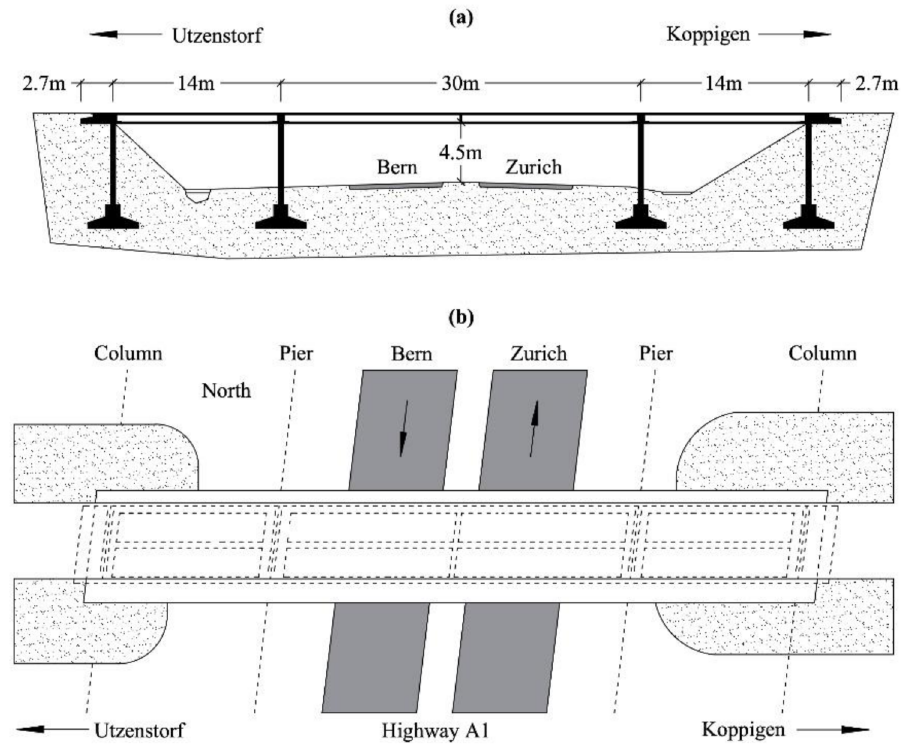
Figure 9. Z24 Bridge: ( a ) longitudinal section and ( b ) top view, adapted from [42]. Starting from the raw data, a modal analysis based on the frequency domain decom- position (FDD) technique was carried out to extract the frequencies of the four fundamental vibration modes and assess their variations due to the environmental conditions. The resulting set of data consists of 3932 measurements, out of which the first 3470 refer to the undamaged, normal condition, and the last 462 ones are associated with the damaged state. Figure 10 collects the exemplary time histories of the modal frequencies relevant to the first and fourth modes: in the plots, the oscillations in the values related to the normal condition were induced by temperature fluctuations in cold periods; these results have clearly testified the high sensitivity of the natural frequencies to the environmental variability. A data normalization procedure based on an auto-associative artificial neural network (AANN) [43] was then adopted to remove such environmental variability from the variation in time of the vibration frequencies and obtain feature samples linked to the damage state only. In compliance with standard approaches in machine learning, 90% of the frequency data regarding the normal condition were handled as the training set, thus including 3123 samples of the four variables (that are the modal frequencies). The last remaining 10% of the frequency values regarding the normal condition, as well as all the values linked to the damaged state were instead handled as the testing set, consisting of 809 samples of the four